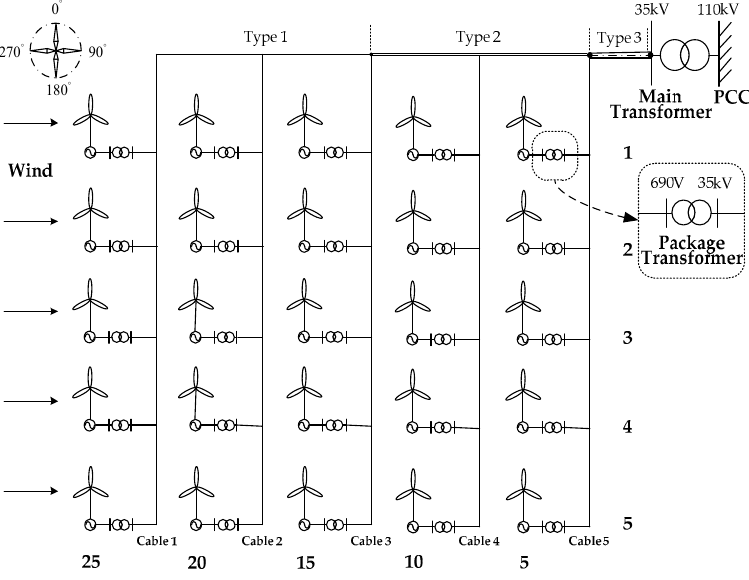
Figure 6. Layout of the wind farm (WF) model.